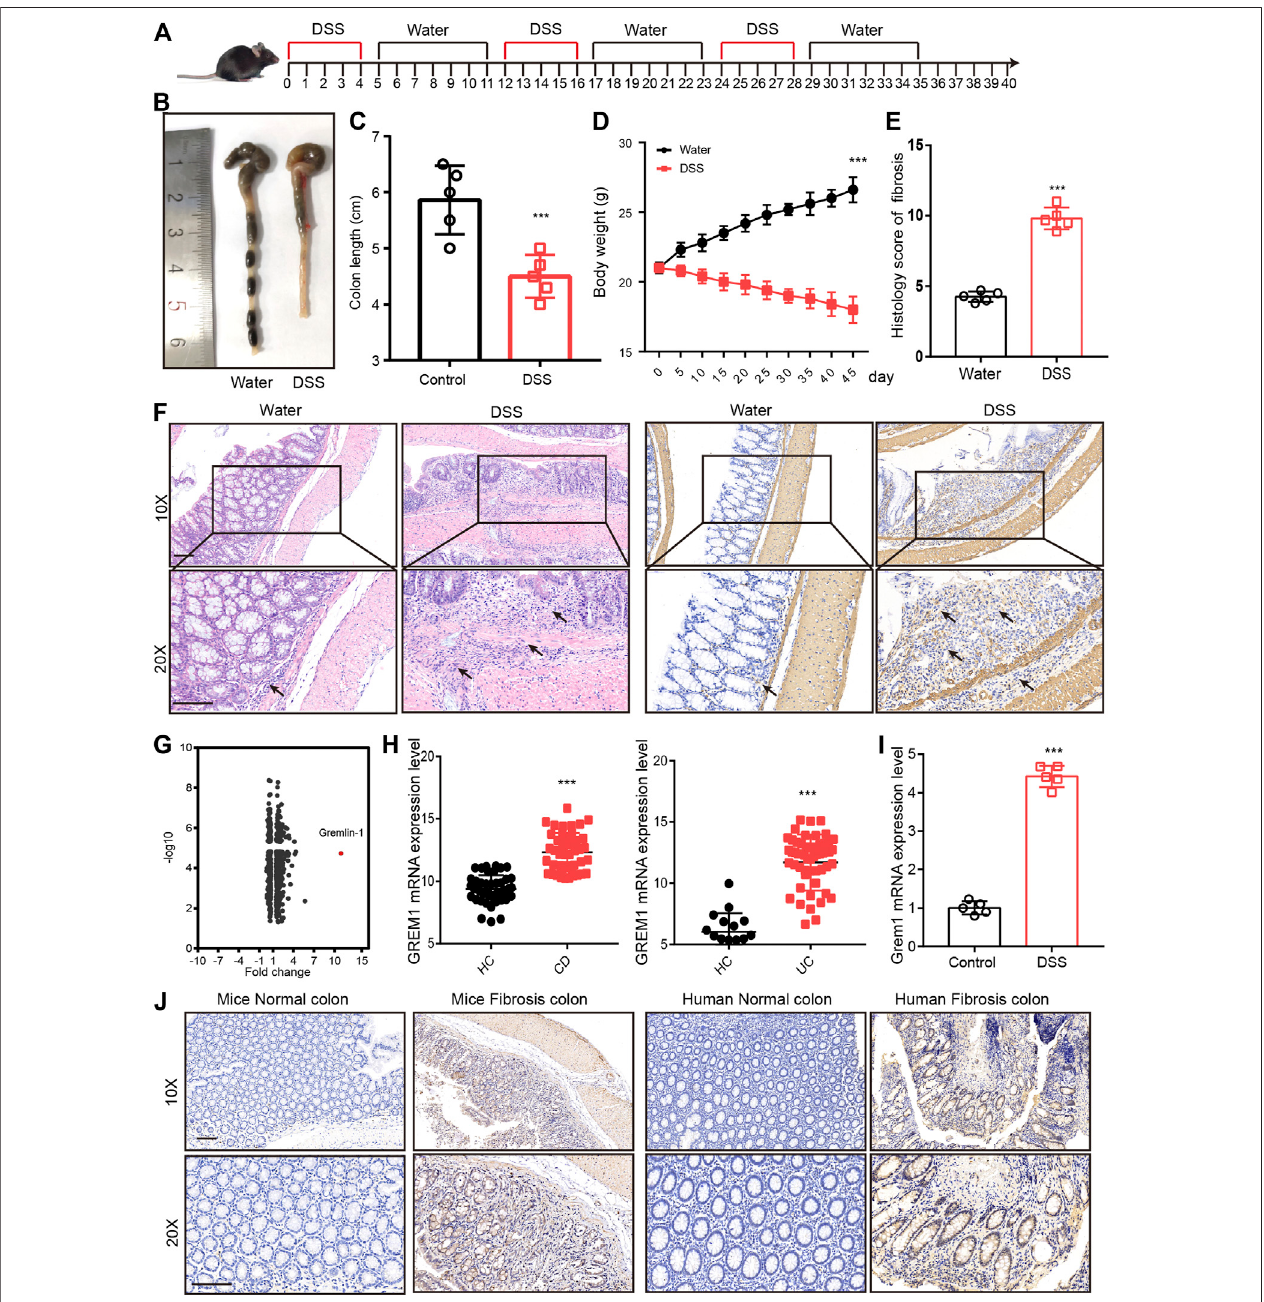
FIGURE 1 | GREM1 expression increased in intestinal fi brosis. (A) . C57BL/6J mice were subjected to three cycles of 2.5% DSS for 5 ° days followed by 1 week of recuperation to establish mice intestinal fi brosis model. (B) . The appearance of the colons from the mice in control or DSS treated groups. (C) . The colon length statical resultsofmicefromcontrolorDSStreatedgroup( n (cid:1) 5). (D) .ThebodyweightcurveofmicereceivedcontrolorDSStreatment( n (cid:1) 5), p valuesarederivedfromone-way ANOVA analysis. (E) . The histology score of intestinal fi brosis mice with different treatment. Fibrosis was quanti fi ed using a combined score of fi brosis severity, circularityandtheextentof fi brosis( n (cid:1) 5). (F) .Thehematoxylinandeosinstaining (leftpanel) and α -SMAIHCstaining (rightpanel) ofdistalcolonsectionsfromcontrol and DSS treated mice. scale bar 200 μ m. (G) . The different expressed protein in DSS treatment mice and control mice that derived from proteomics analysis. (H) . The mRNA expression of GREM1 (human) in healthy control (HC) and IBD patient ’ s data from SRP077046 and SRP100787. (I) . The mRNA expression of Grem1 in control andintestinal fi brosismice( n (cid:1) 5). (J) .IHCstainingofGREM1inbothmiceandhumaninintestinal fi brosistissues.scalebar200 μ m. p valuesarederivedfromtwo-sided Student ’ s t test. ** p ≤ 0.01; *** p ≤ 0.001.